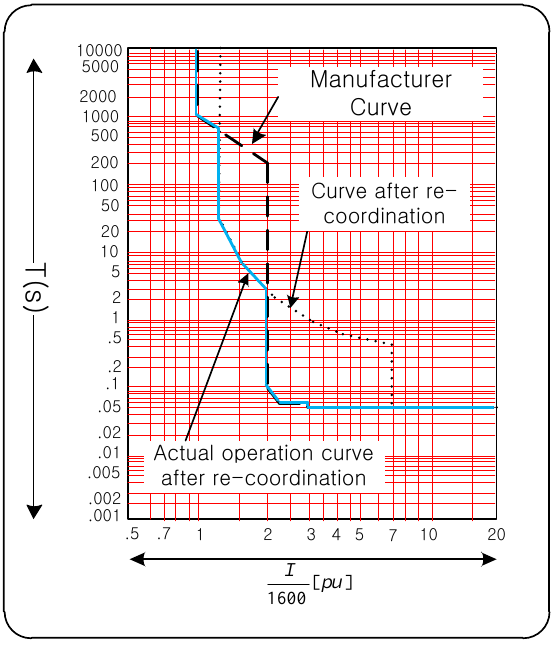
Figure 5. Re-coordination curve of the OCR for generator.